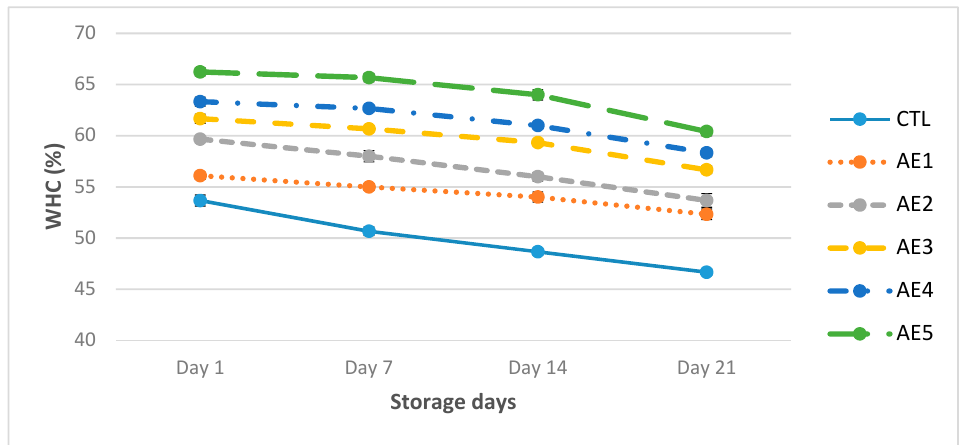
Figure 2. Water holding capacity of probiotic yoghurt with addition of APPE. CTL: Without APPE;